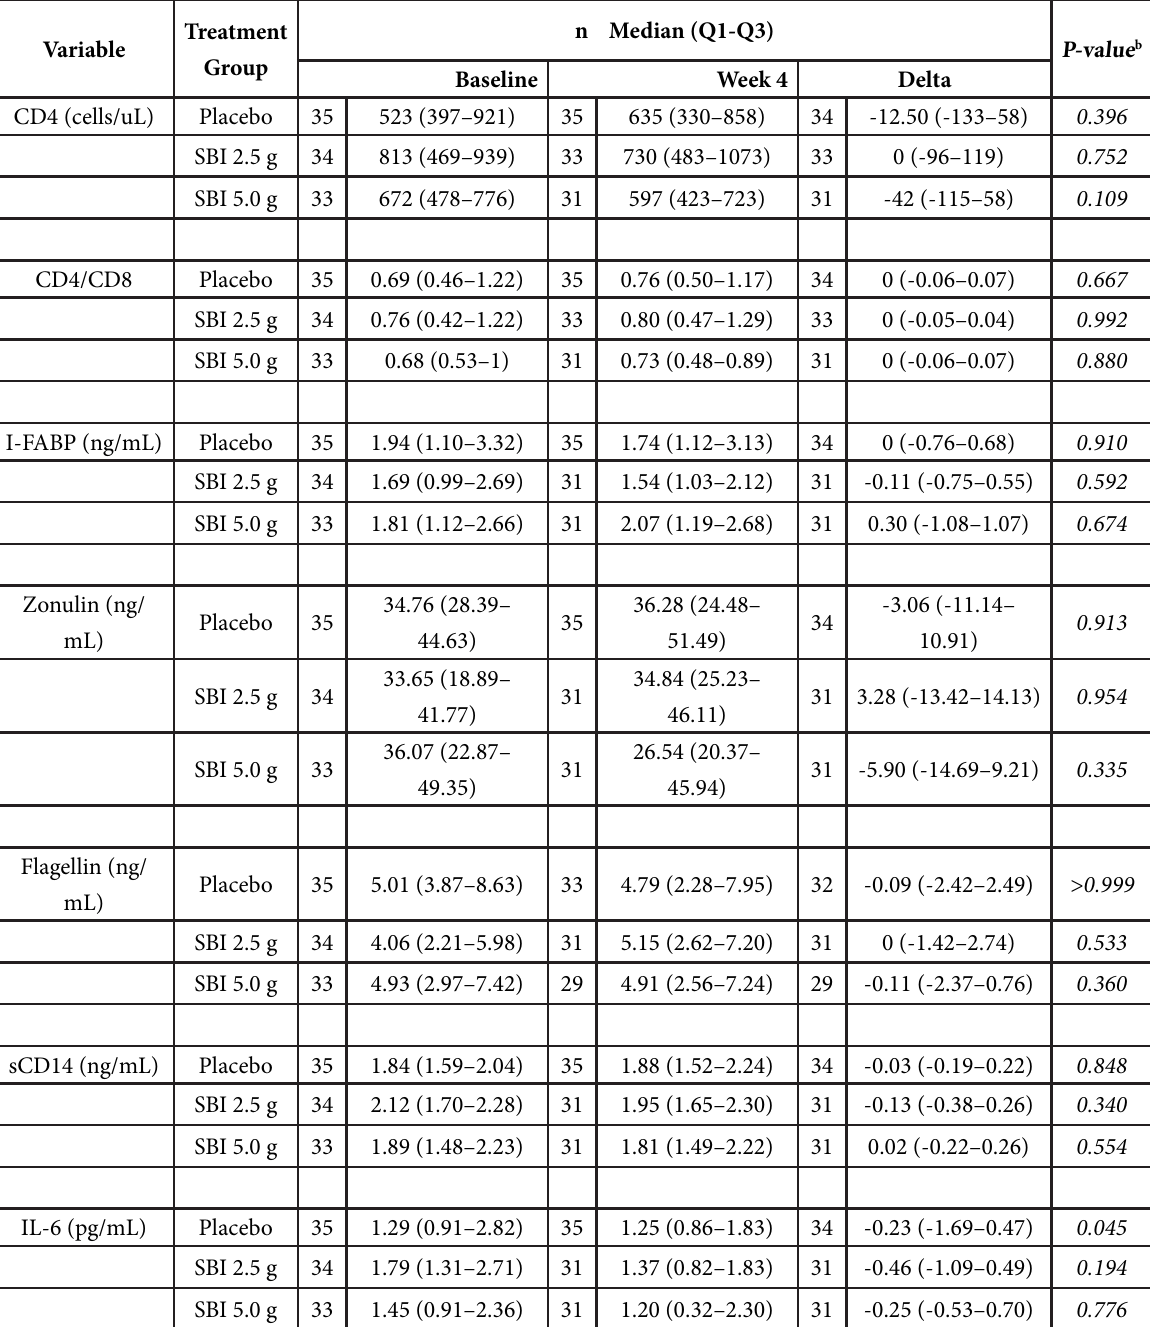
Supplementary Table 1. Within-Group Comparisons for Randomized Treatment Groups